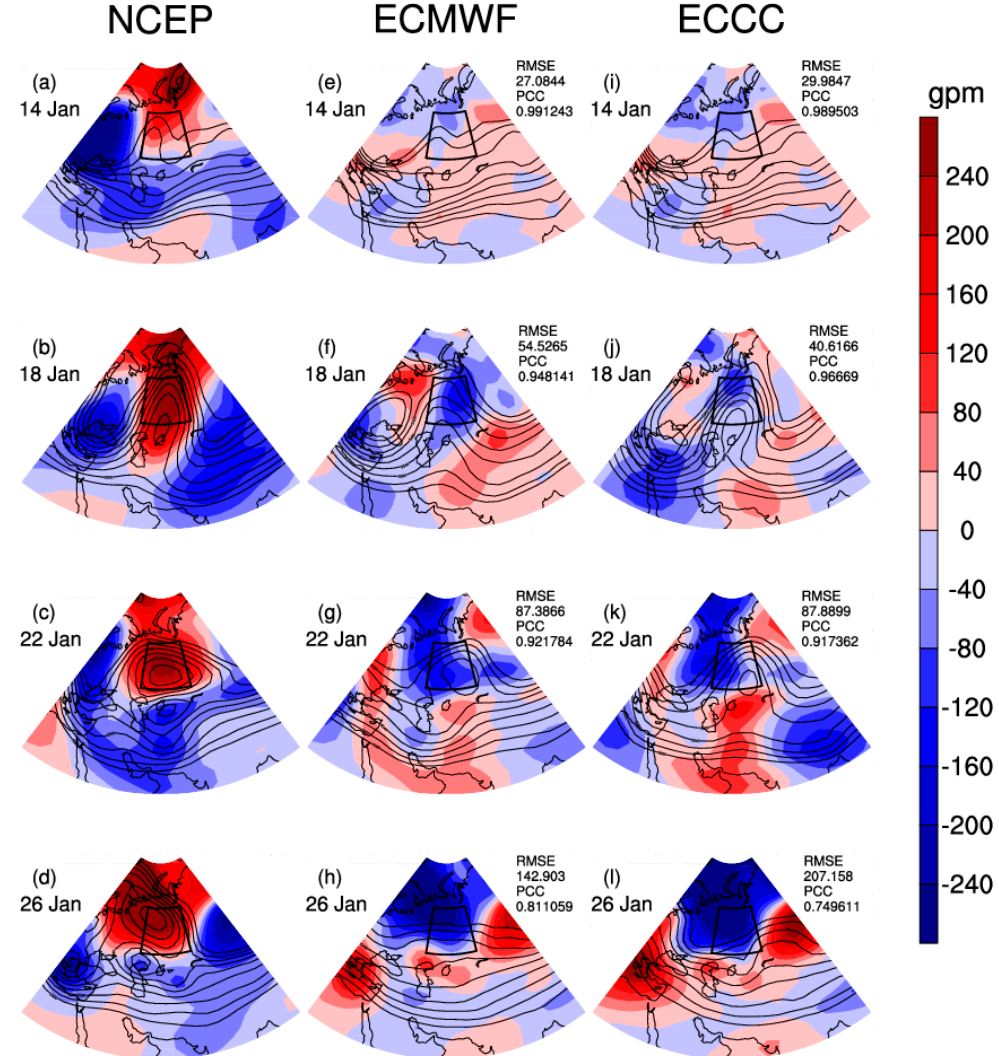
Figure 2. Evolution of the Z500 (contour interval, 40 gpm) and Z500 anomalies (shaded, gpm) in ( a – d ) the observations from January 14 to January 26, 2012. Evolution of the Z500 difference between the two model predictions and observation (shaded, gpm) and Z500 (contour interval: 40 gpm) in ( e – h ) the ECMWF predictions initialized on January 12 and ( i – l ) the ECCC predictions initialized on January 12. The RMSE and PCC between the predictions and the observations over the region (20–80° N, 20–100° E) are indicated at the top right.